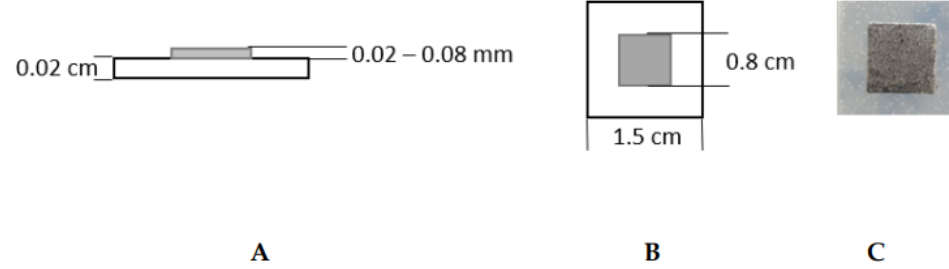
Figure 1. Schematic of the samples prepared with silicone rubber (white) and galinstan (grey). ( A ) Cross section of sample showing the material height; ( B ) top view of sample showing the material width; ( C ) microscopic image of galinstan square on silicone–rubber substrate.